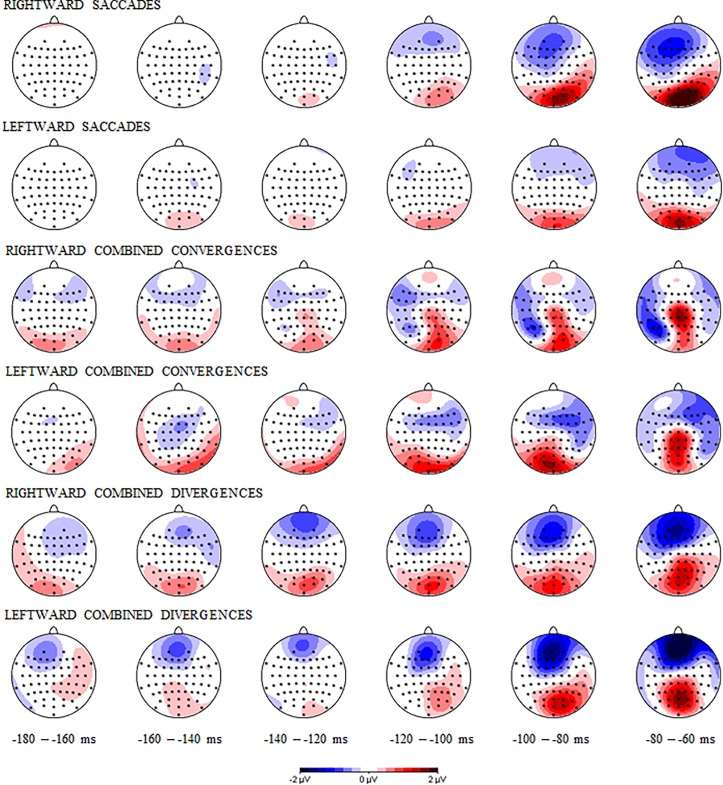
Topographical maps of event-related potentials for the three eye movement types from -180 ms to -60 ms before eye movement onset.The first two rows display the maps for pure left and right saccades, the third and fourth row show the maps for combined left and right convergences, and the two lower rows represent the maps for left and right combined divergences.